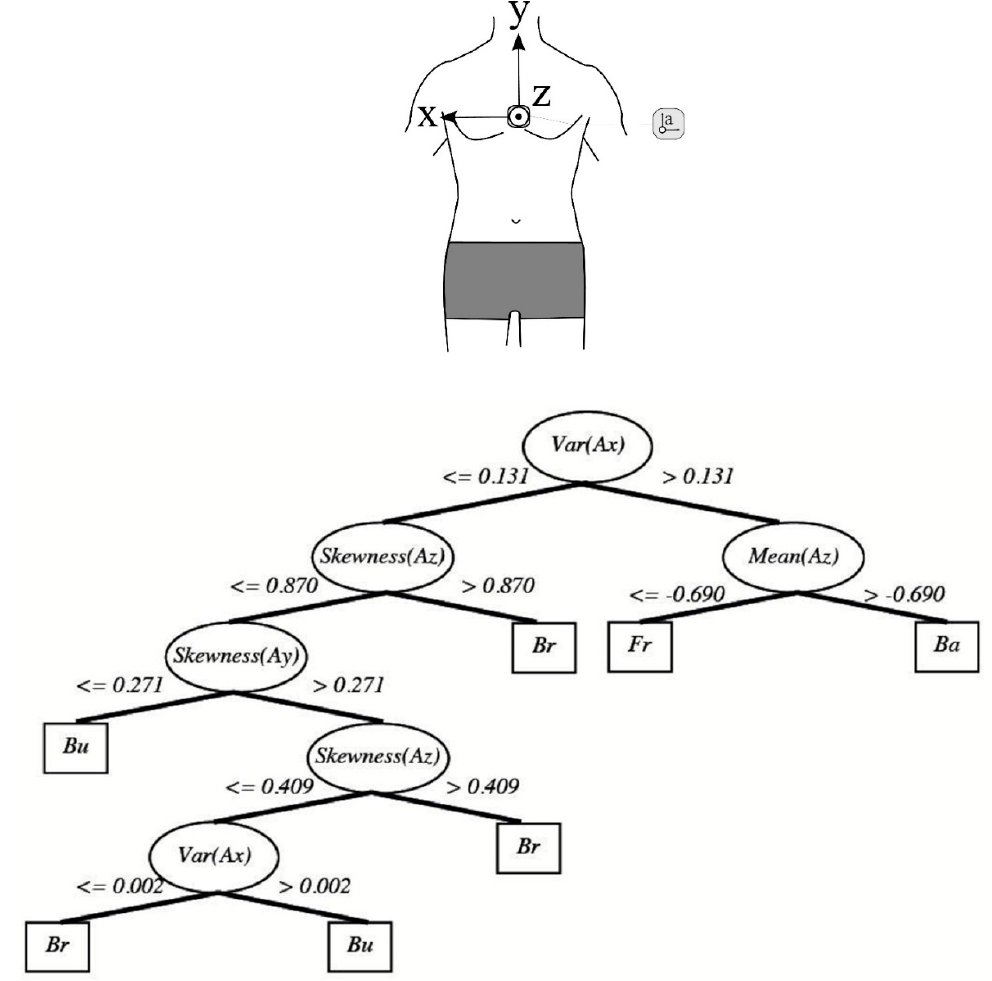
Figure 11. Stroke identification classification model based on descriptive statistical features of all three axes of the acceleration signal from a chest worn device. Thresholds were set to the data from each of the three axes (values in m ∙ s -2 ) in order to classify stroke styles. Reproduced with permissions from Ohgi, Kaneda and Takakur [93].